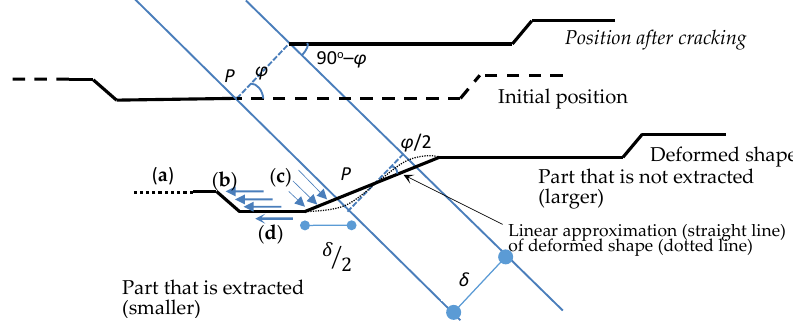
Figure 4. Modeled deformation of a single fiber crossing a crack ( ϕ is the inclination of the fiber from